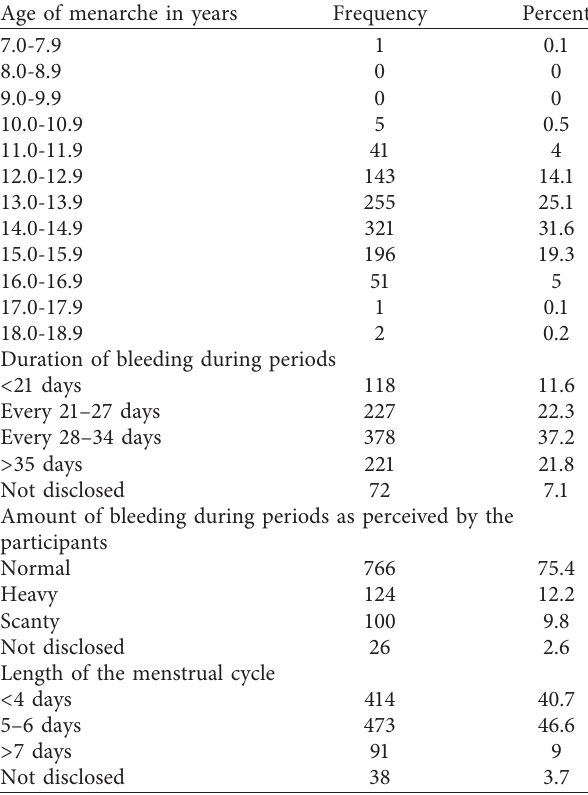
Table 3: Menstrual hygiene practices among the participants by the place of residence.